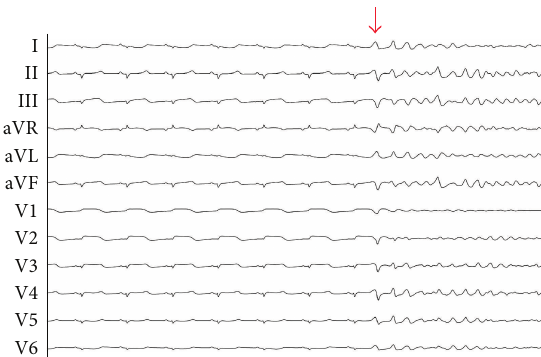
Figure 1: Ventricular fibrillation initiated by premature ventricular depolarization.